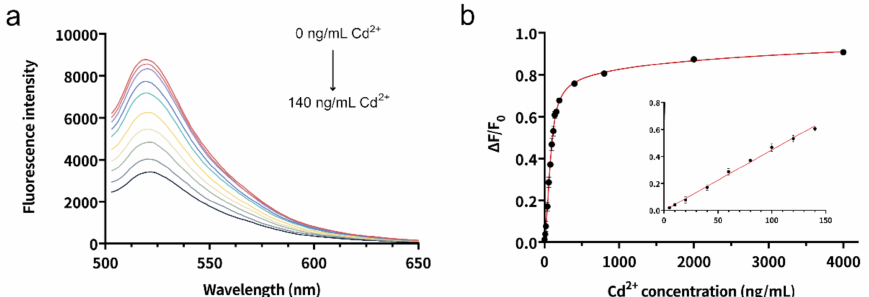
Figure 5. ( a ) Fluorescence emission spectra of the aptasensor on exposure to 0, 5, 10, 20, 40, 60, 80, 100, 120, and 140 ng mL − 1 Cd 2+ . ( b ) Calibration curves of the aptasensor for Cd 2+ determination. (Insert) Initial linear responses in the range of 5 − 140 ng mL − 1 Cd 2+ . (n ≥ 4). C : Cd 2+ concentration; R 2 : correlation